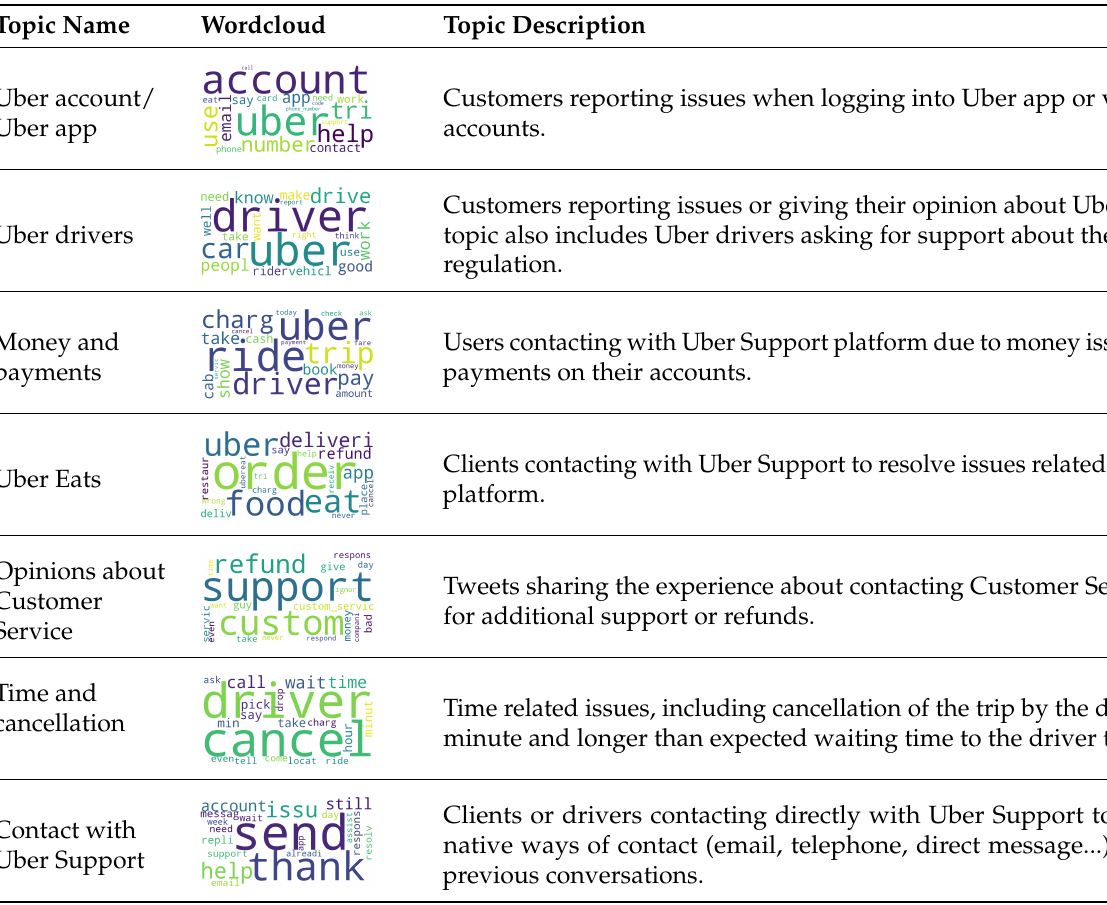
Table 3. Description of the seven latent topics from the dataset with their most frequent words using LDA topic